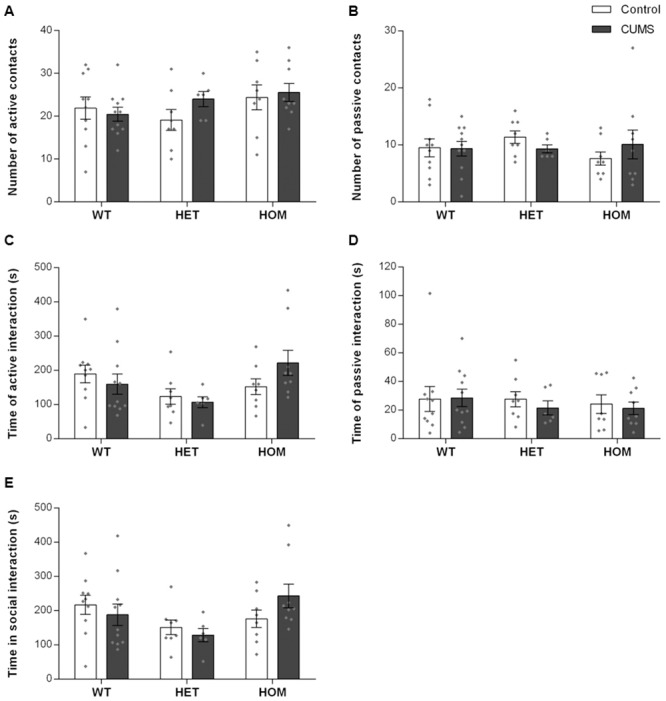
CUMS exposure did not alter maternal aggression responses to intruders in Shank3ex4-9 mutant dams.(A, B): Number of active (A) and passive (B) social contacts by dams during maternal intruder test. (C, D): Time dams spent in active (C) and passive (D) social interaction with the intruder. (E): Time spent in social activities during maternal intruder test. CUMS exposure and genotypes did not affect any of the parameters assessed during the maternal intruder test. WT: Wildtype; HET: Heterozygous; HOM: Homozygous. N = Control (11 WT, 8 HET, and 8 HOM) and CUMS (11 WT, 6 HET, and 9 HOM). Individual data points are represented by diamonds.